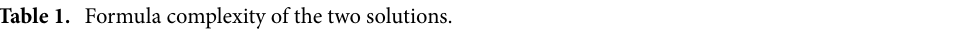
unit vectors e 3 . The direction of the unit vector e 1 is set to the orbit radius of the base satellite, while is perpendicular to the orbit plane of the base satellite. The unit vector